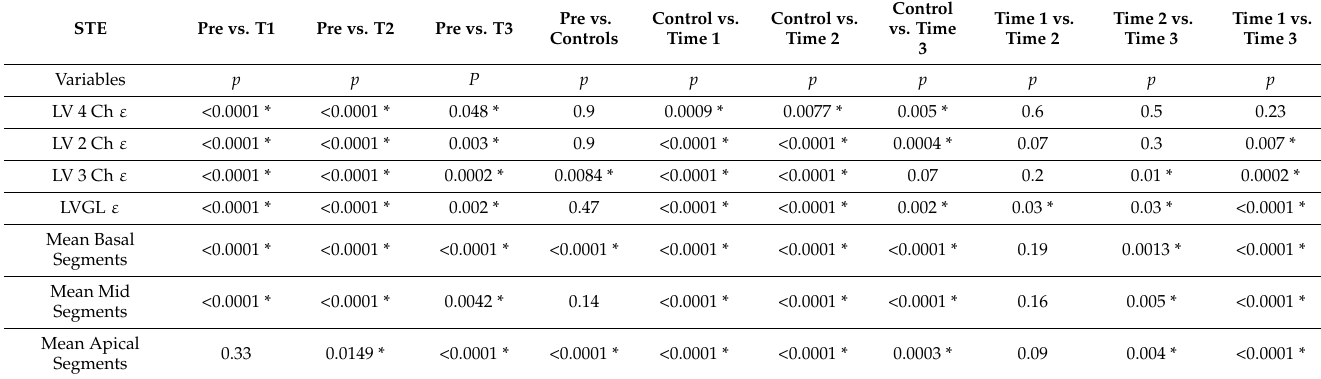
Table 4. Differences among mean and standard deviation of LV global ε values and segmental ε values at different time evaluations and comparison with healthy